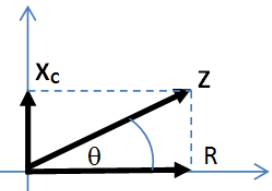
Figure 2. The relation of R, Xc, and Z.